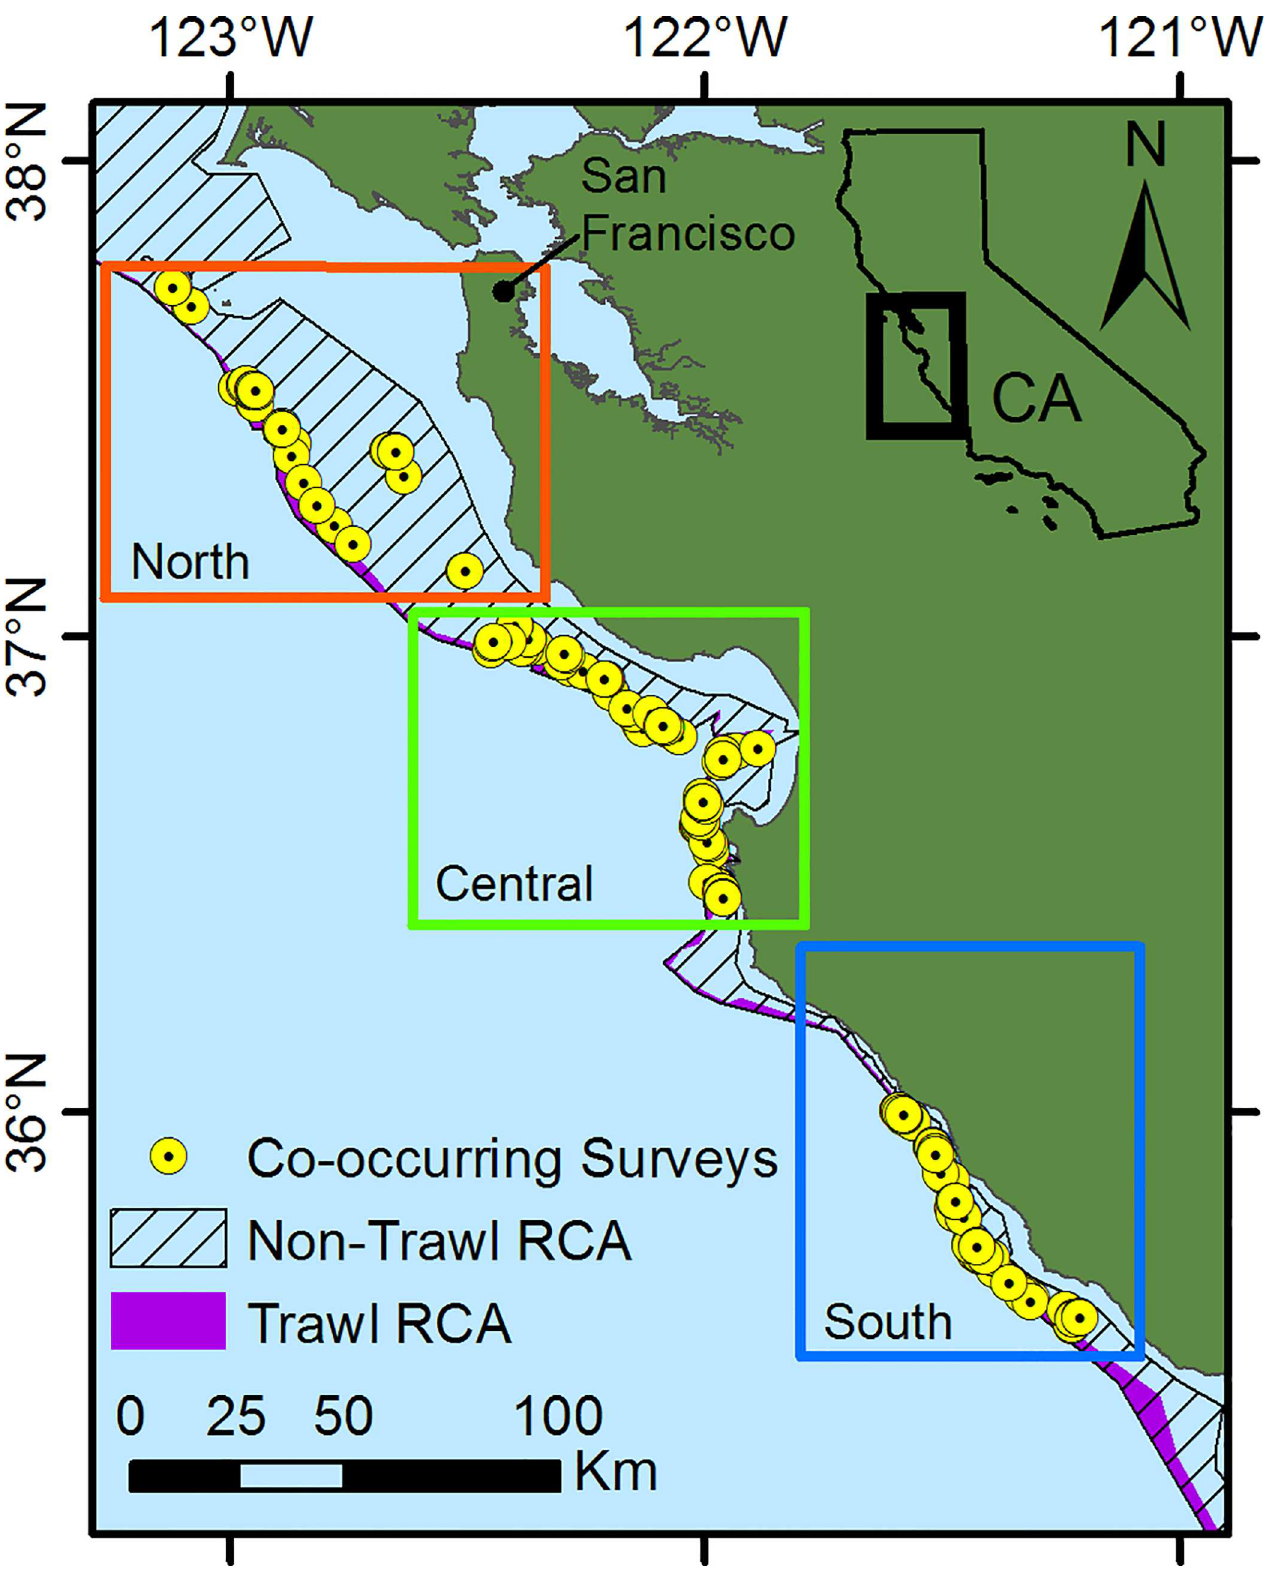
Fig 1. Map of locations of co-occurring video and fishing surveysin three sub-regions of central California, USA.